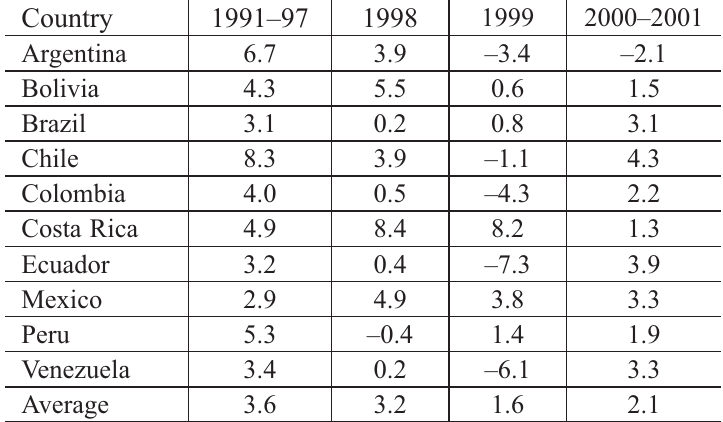
Table 1. Real GDP Growth Rate (Percentages)